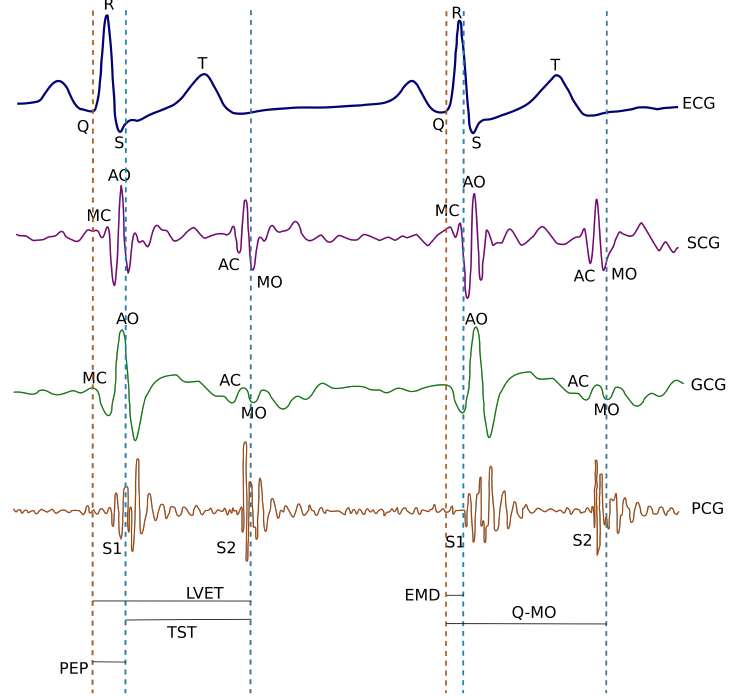
Figure 1. Simultaneous sample recordings of ECG, SCG (z-axis), GCG (y-axis), and phonocardiographic (PCG) signals captured in the supine position. The MC and MO waves in SCG and GCG correspond to mitral valve closure and opening; the AC and AO waves in SCG and GCG corresponded to the aortic valve closure and opening. S1 and S2 waves on PCG corresponded to mitral and aortic valve closure, respectively. EMD (electromechanical delay), PEP (Pre-ejection period), TST (total systolic time) and LVET (left ventricular ejection time) and systolic time intervals are also illustrated. The diagram is a modified version of the diagram originally published in the article by Dehkordi et al. in [42] with a GCG y-axis waveform derived from a diagram published in the work by Tadi et al. [11]. The cited works are available under the license CC-BY